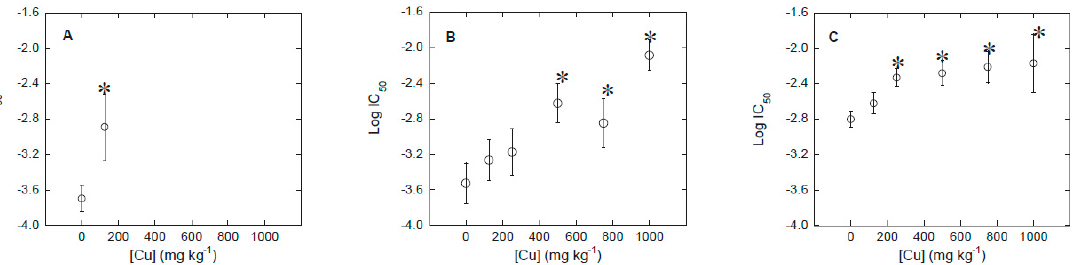
Figure 2. Variation of bacterial community tolerance to Cu (expressed as log IC 50 ), as a function of Cu concentration in the soil. ( A ): soil 1; ( B ): soil 2; and ( C ): soil 3. * Indicates significant increases in log IC 50 compared to the control log IC 50 ( p < 0.05).